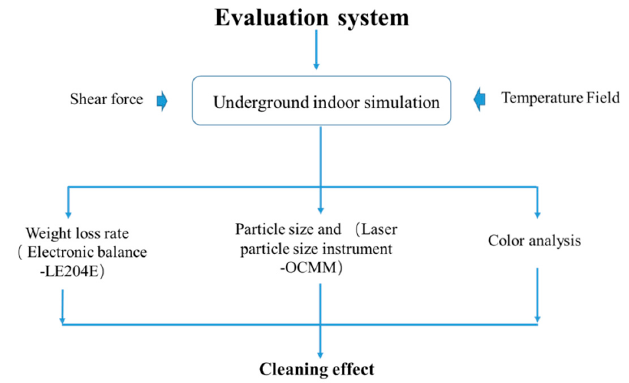
Figure 4. Cleaning fluid evaluation model.